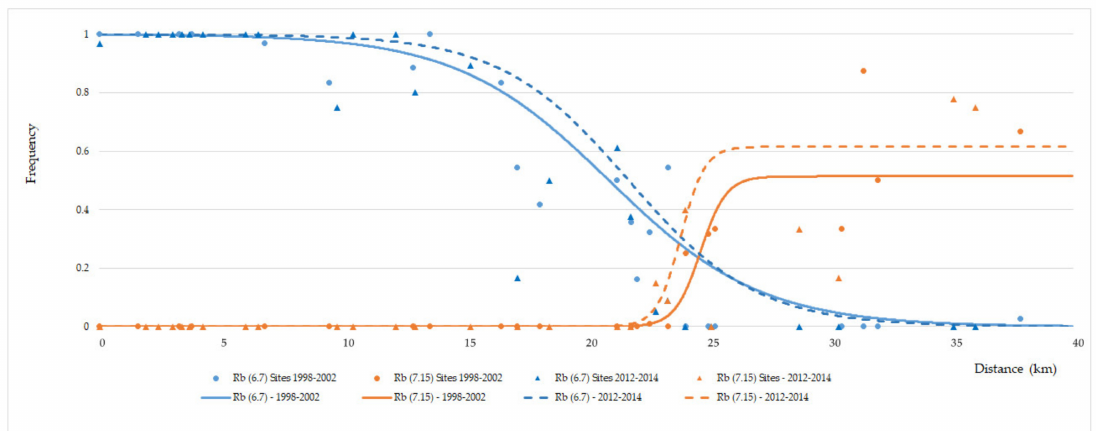
Figure 4. Comparison of clinal patterns for fusions Rb (6.7) (blue) and Rb (7.15) (orange) between the periods 1998–2002 (circles and full line) and 2012-2014 (triangles and dashed